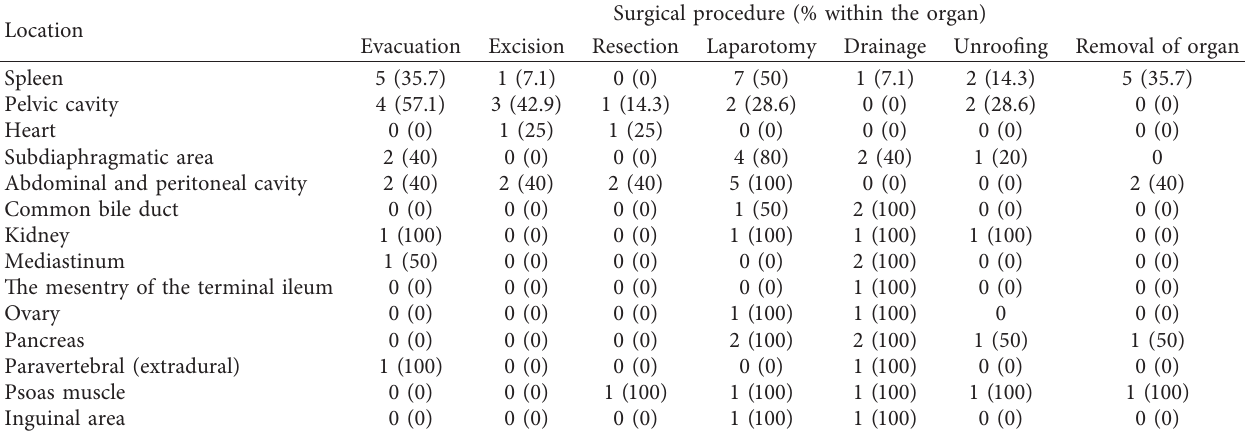
Table 3: Surgical procedures performed regarding hydatid cysts in uncommon